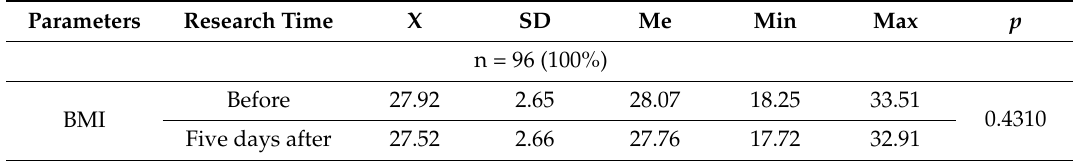
Table 3. Statistical analysis of the nutritional status of patients who underwent CABG based on BMI. Parameters